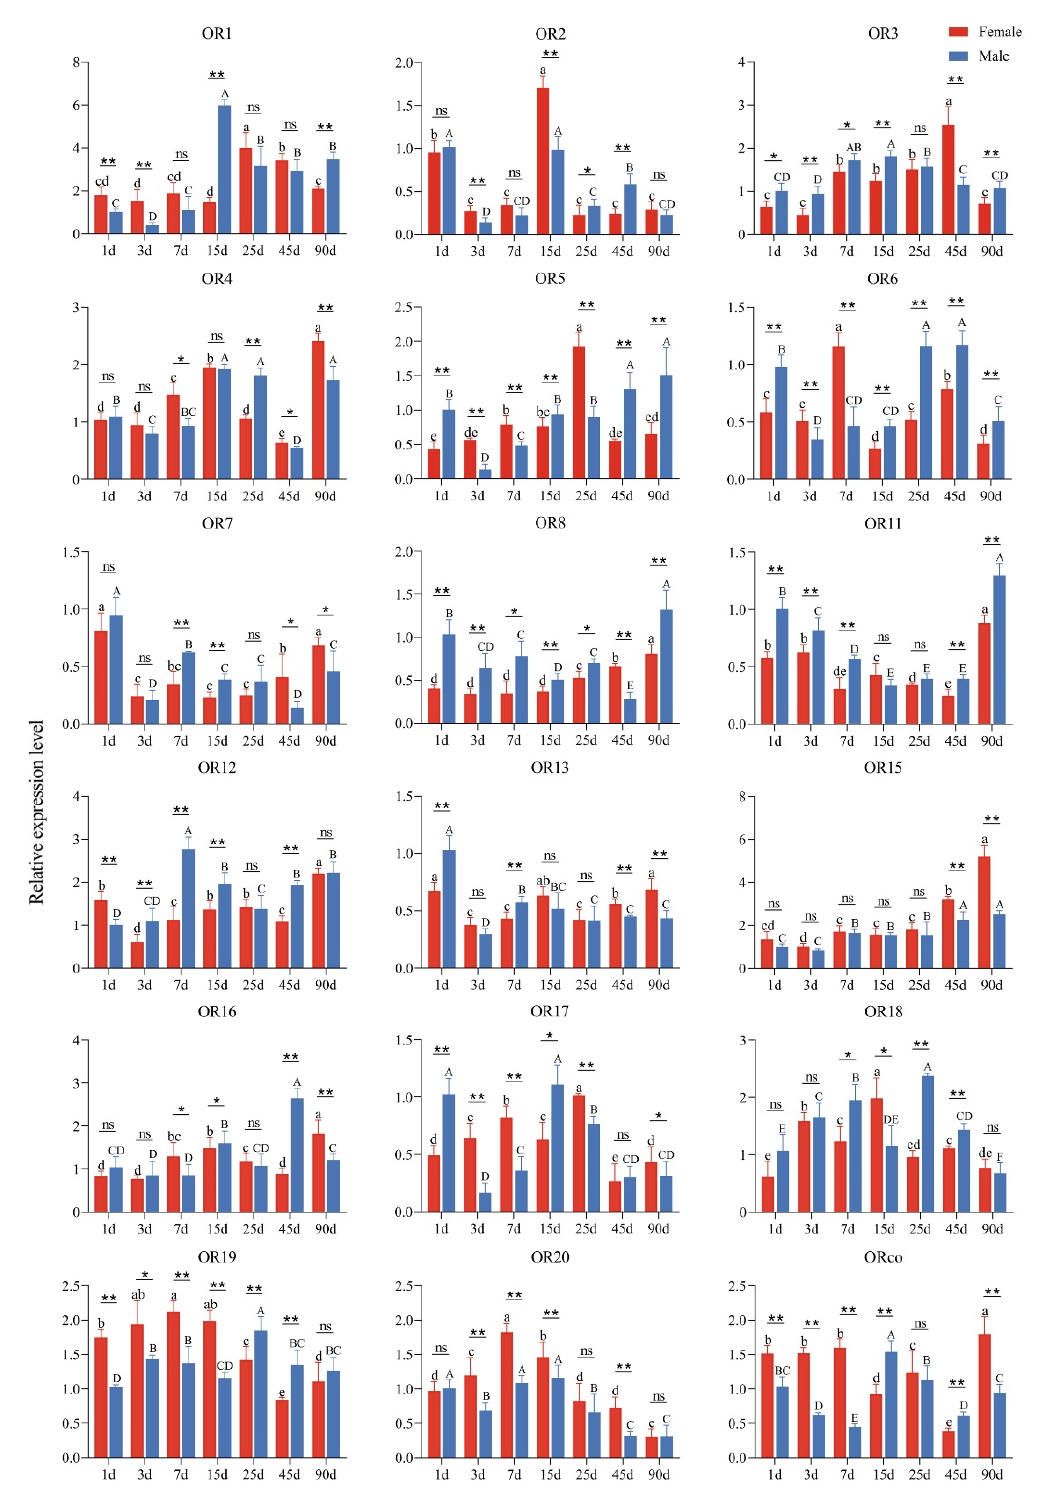
Figure 2. Expression profiles of GdauORs at different days after eclosion of antennae in female and male adults. 1 d: 1-day-old; 3 d: 3-day-old; 7 d: 7-day-old; 15 d: 15-day-old; 25 d: 25-day-old; 45 d: 45-day-old; 90 d: 90-day-old. Error bars represent the standard error of three independent experiments. Different capital and small letters above bars indicate significant difference among different developmental days of female and male, respectively (Duncan’s test; p < 0.05). The asterisk above bars indicates significant difference between males and females ( T -test; *: p < 0.05; **: p < 0.01; ns: No significant